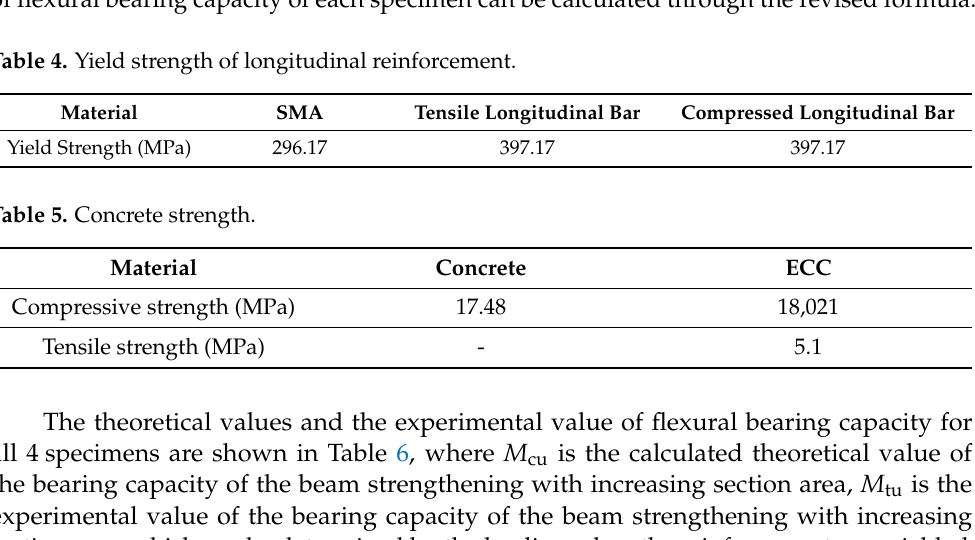
Table 5. Concrete strength.